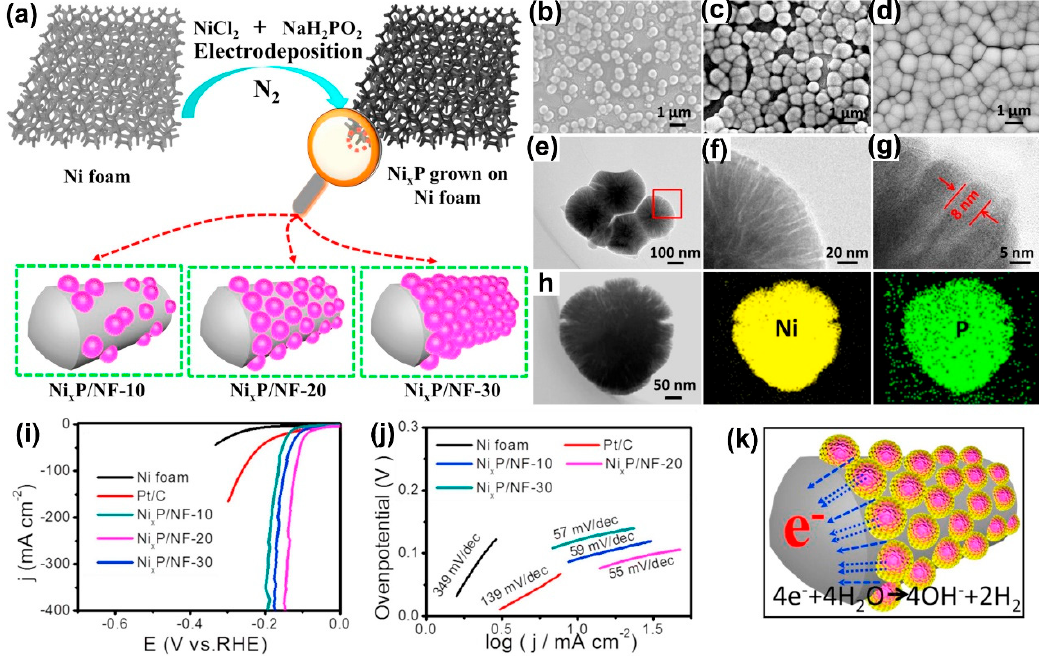
Figure 13. Schematic illustration for the electrochemical deposition of hierarchical radial Ni x P nanospheres on Ni foam ( a ), SEM images of Ni x P / NF-10 ( b ), Ni x P / NF-20 ( c ), and Ni x P / NF-30 ( d ), TEM image of radial Ni x P-10 nanospheres ( e ), the magnified TEM image of a red squared indicated area ( f ), HRTEM ( g ), and elemental mapping images of the radial Ni x P-10 nanospheres ( h ). iR-corrected LSV curves for Ni x P / Ni foam, pristine Ni foam, and Pt / C electrodes for HER ( i ) and corresponding Tafel plots ( j ), and schematic illustration of the advantages of the brushy surface of Ni x P / NF-20 for HER ( k ). Reproduced with permission from Reference [131], Copyright Elsevier B.V., 2018. Table 8. Summary of the nickel phosphide electrocatalysts prepared through electrochemical deposition for HER.